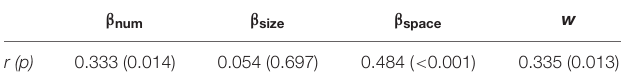
TABLE 2 | Inter-test